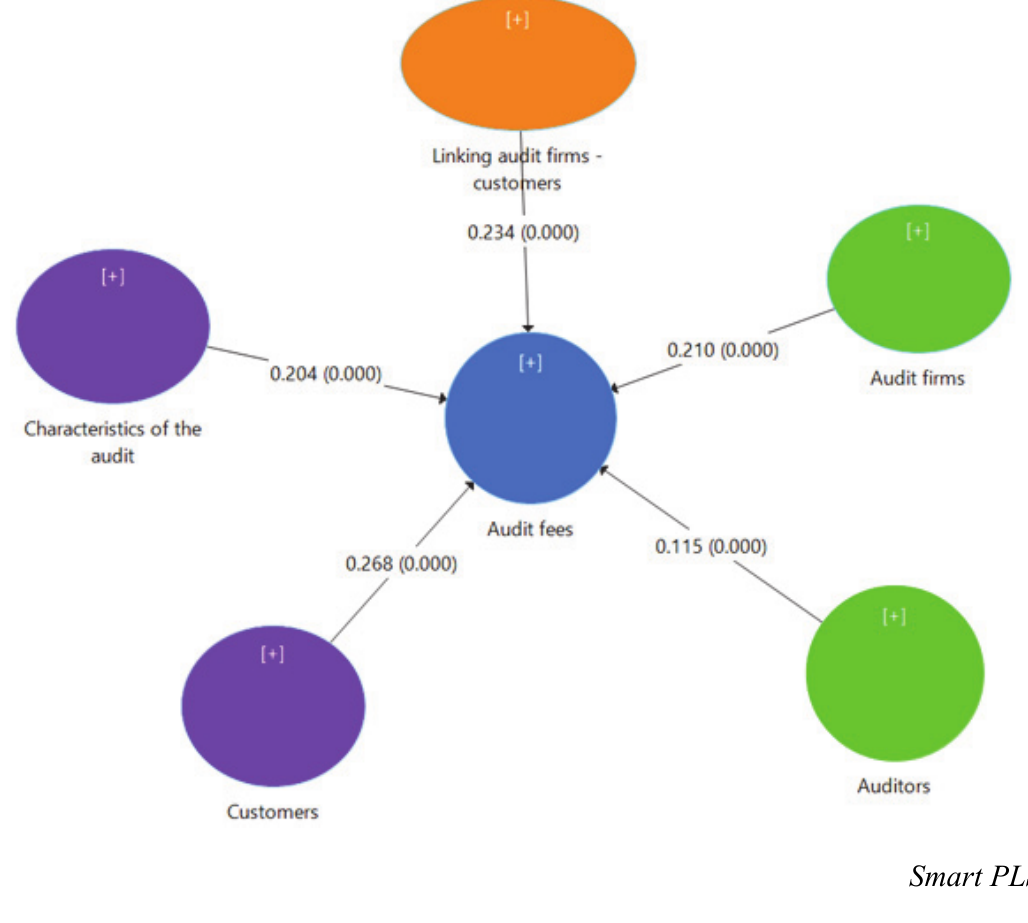
Fig. 2. Hypothesis test results by Boostrap